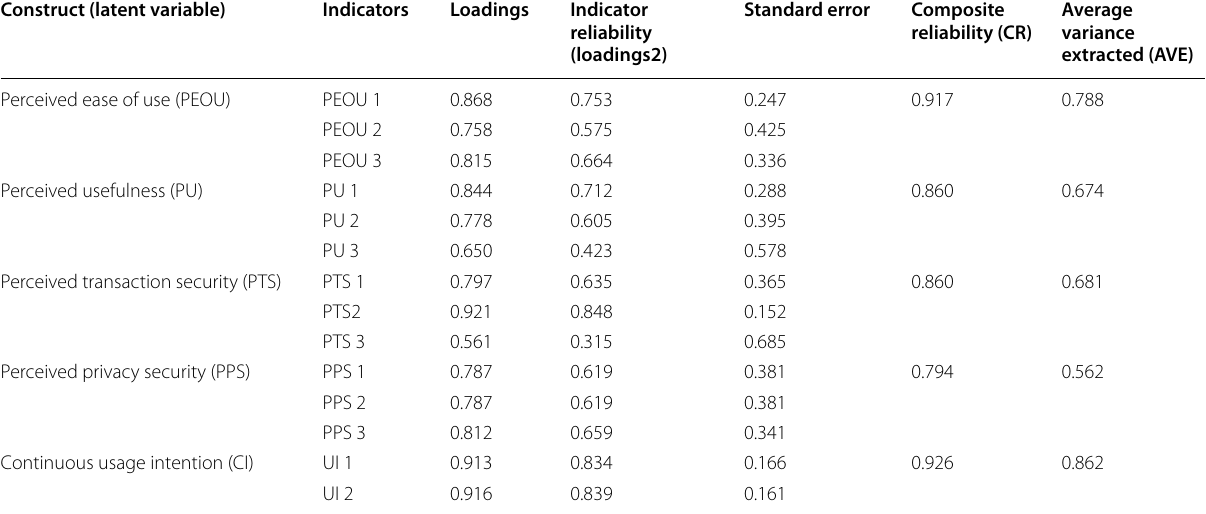
Table 4 Results of the factor loadings, validity and reliability Construct (latent variable)